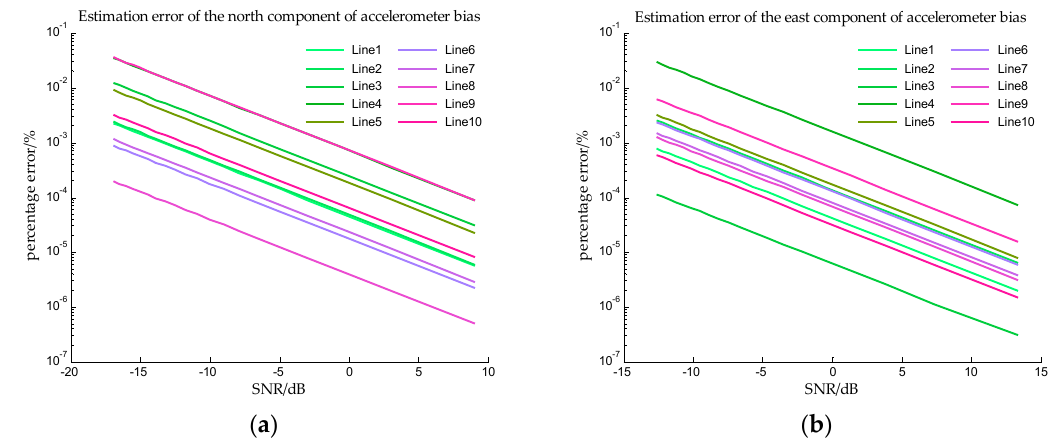
Figure 17. The estimation error of accelerometer bias on the short survey lines in simulation IV. ( a ) Is the estimation error of the north component of the accelerometer bias, and ( b ) is the estimation error of the east component of the accelerometer bias.